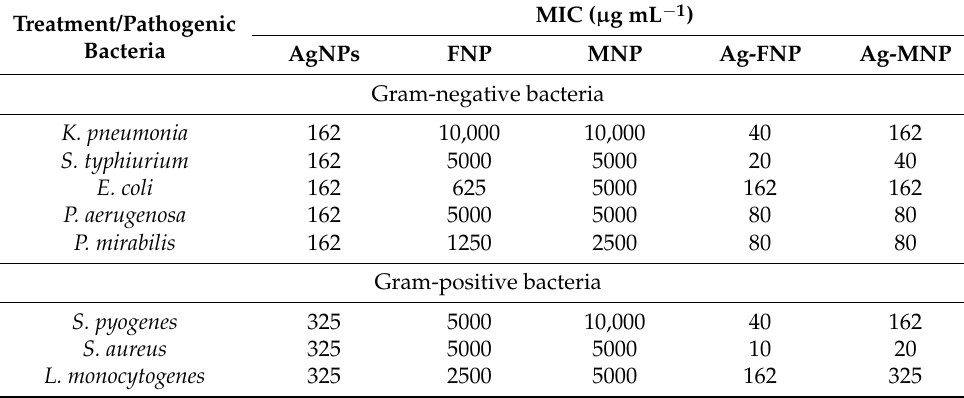
Table 2. Minimum inhibitory concentration (MIC; µ g mL − 1 ) of tested proteins against Gram-positive and Gram-negative